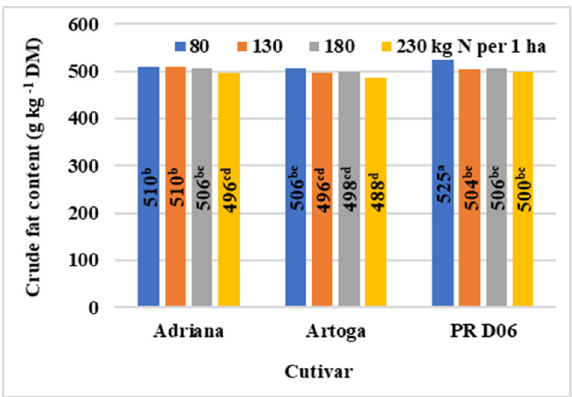
Figure 10. The effect of N rate on the crude fat content of winter oilseed rape seeds, across years. Means with the same letters do not differ significantly at p ≤ 0.05 in Tukey`s test. Energies 2020 , 13 , 4654